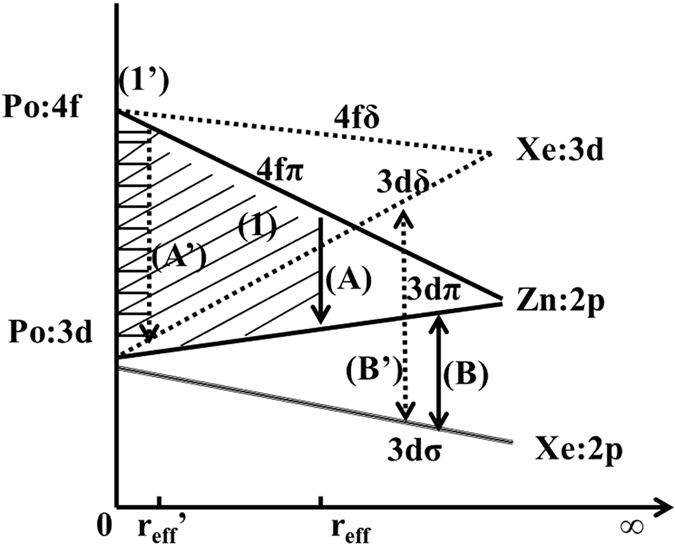
Molecular correlation diagram (a qualitative estimate of the Xe + Zn molecular levels).(1) and (1’): MO transition region; (A) and (B): MO transition and electron promotion for a Xeq<29++ Zn atom collision; (A’) and (B’): MO transition and electron promotion for a Xe 29++ Zn atom collision; reff (r’eff): effective range of MO transition induced by Xeq<29+ (Xe29+).